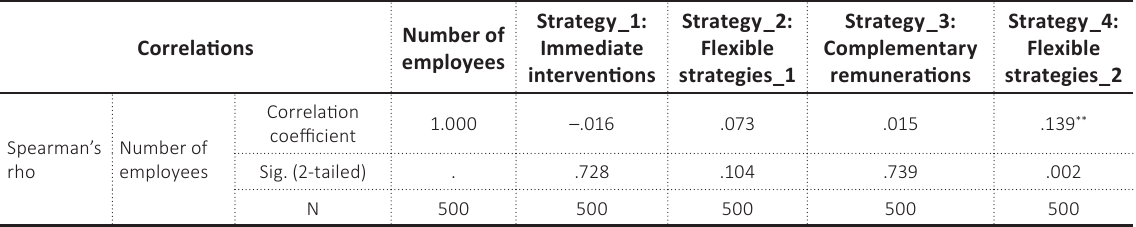
Table 10. Correlations between firm size and use of non-wage methods